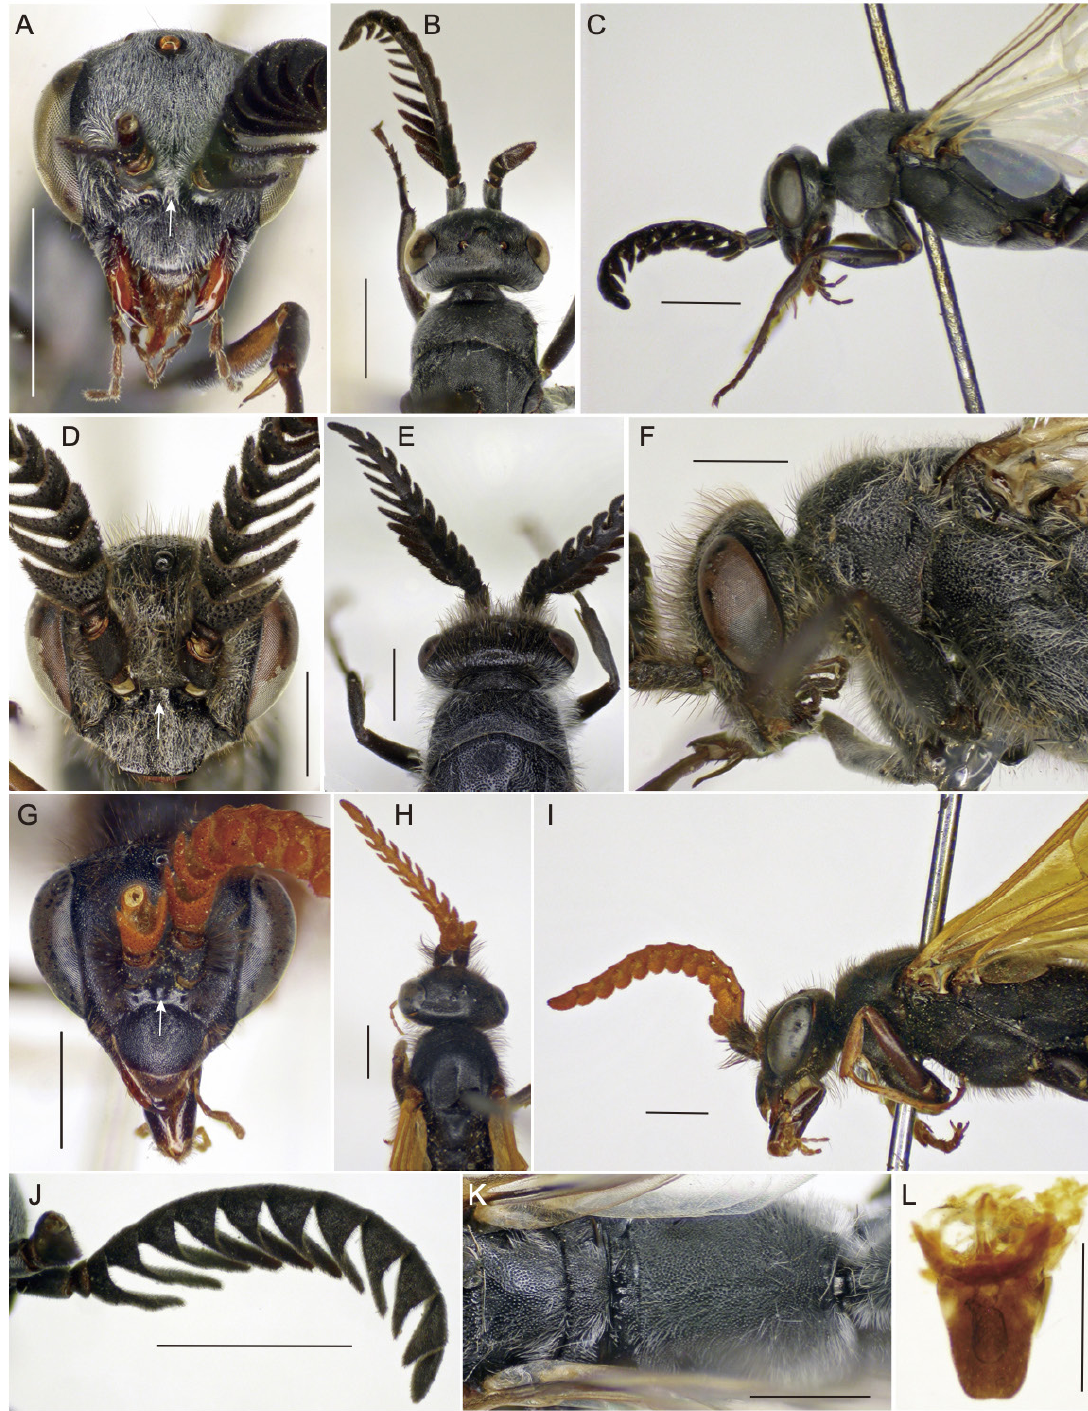
Fig. 4. Males of Ctenocerus Dahlbom, 1845. A–C, J, L . C. lacteipennis (Arnold, 1932) (#13) (NHMUK). D–F, K . C. klugi Dahlbom, 1845 (#11) (NHMUK). G–I . C. ramosus Smith, 1865 (#18) (UMUT). A, D, G . Head, anterior view, arrow indicates frontal bridge. B, E, H . Head and anterior part of mesosoma, dorsal view. C, F, I . Head and mesosoma, lateral view. J . Left flagellum, mesial view. K . Posterior part of mesosoma, dorsal view. L . Subgenital plate, ventral view. Numbers in parentheses after species names are specimen numbers in Supp. file 1. Scale bars: A–K = 1 mm; L = 0.5